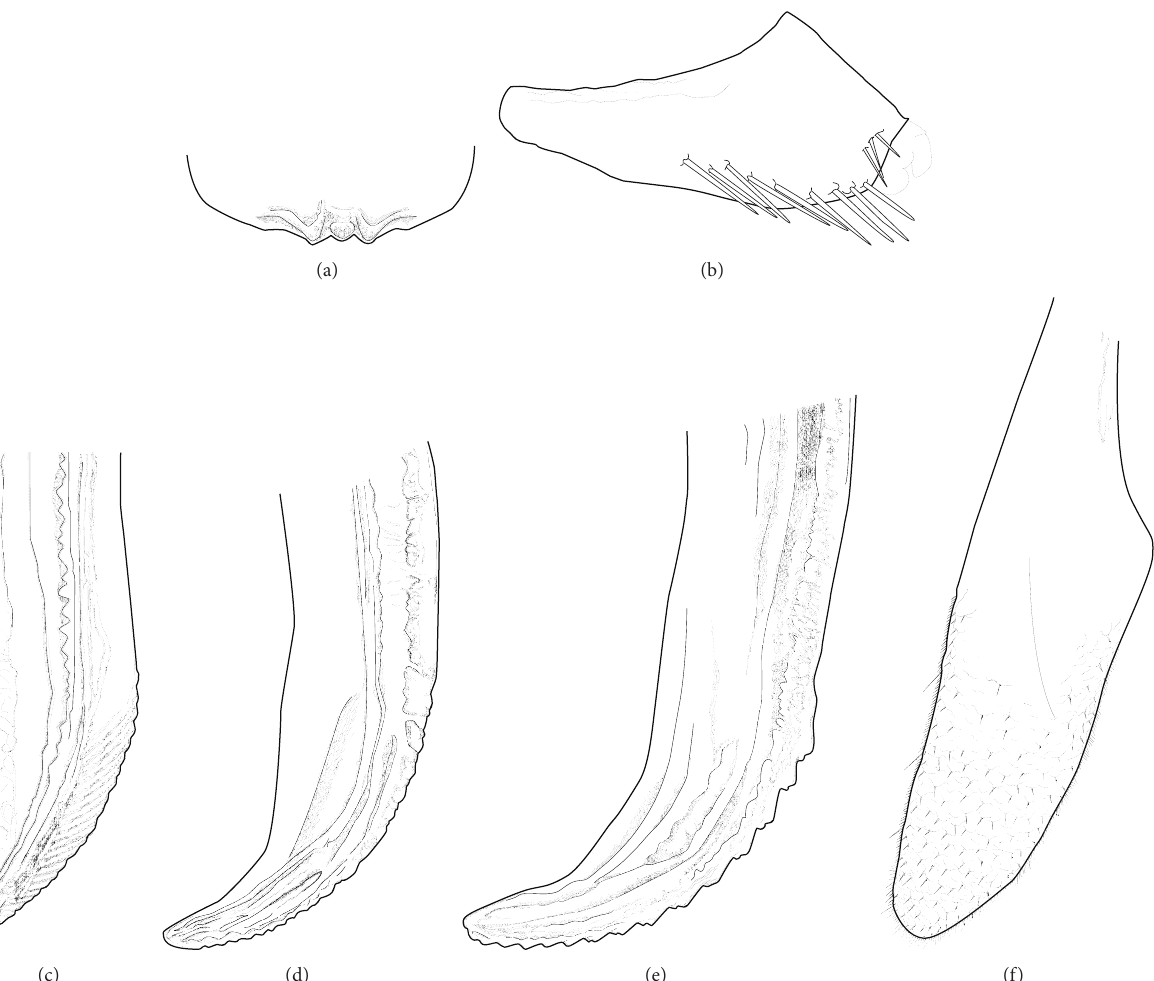
Figure 3: Dikrella caryocar n. sp. (female genitalia): (a) seventh sternite (ventral); (b) pygofer (lateral); (c) valvulae I; (d) valvulae II (left); (e) valvulae II (right); (f) valvulae